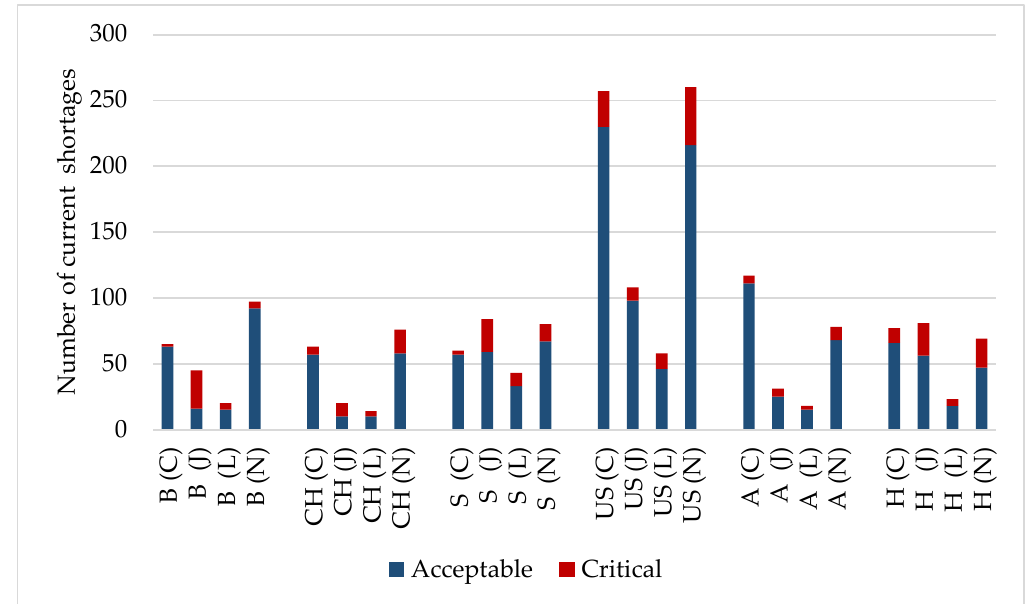
Figure 1. Number of shortages according to ATC groups (including both critical and non-critical).